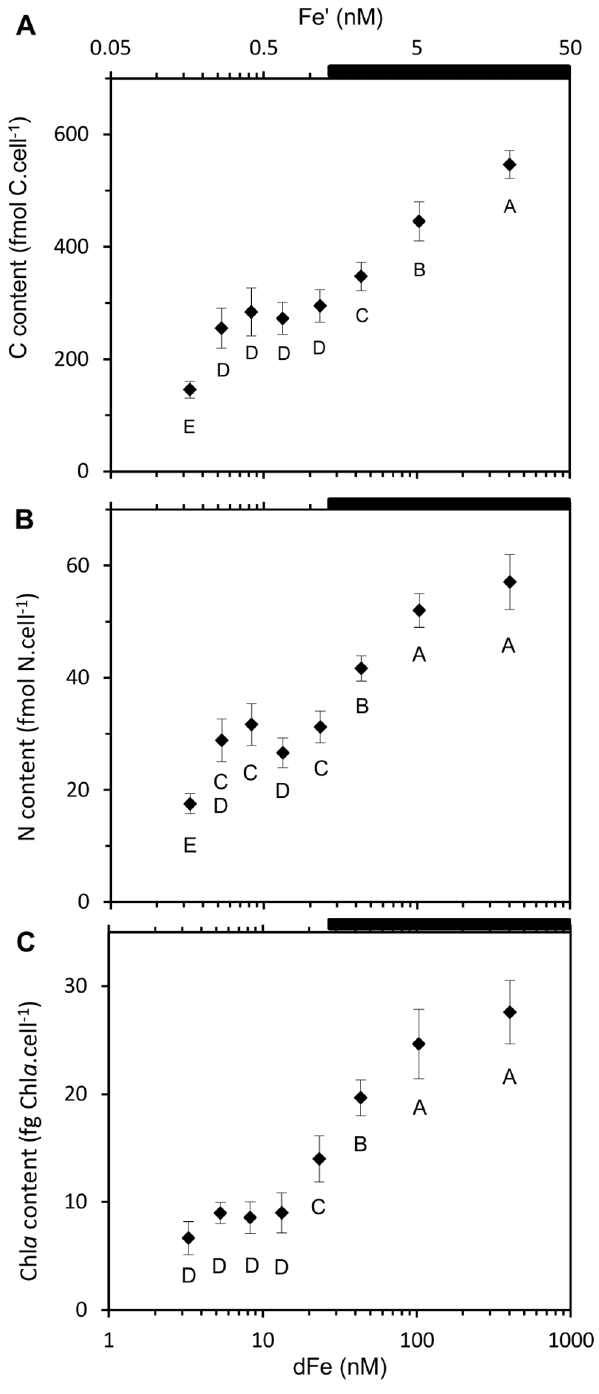
Figure 3. Influence of Fe availability on the elemental composition of C.watsonii . Mean cellular content of C (A), N (B) and Chl a (C) related to dFe and Fe 9 concentrations, in log scale. Error bars represent standard deviation; different letters correspond to statistically different means ( p , 0.05) and the black bar indicates the region of expected Fe hydroxide precipitation. (an amorphous oxidized Fe hydroxide) via cell surface adsorption and biological mediated dissolution. [55] have shown that Trichodesmium and the non-diazotrophic unicellular cyanobacteri-